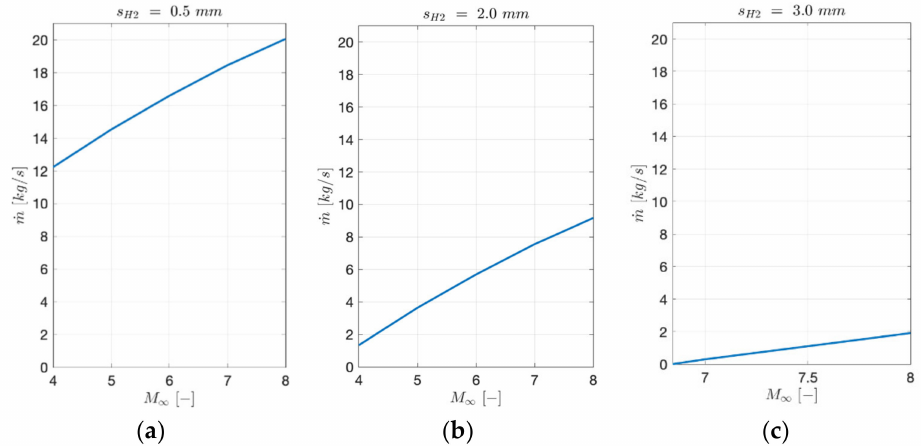
Figure 21. ( a ) Variation of the overall air mass flow supplied by the ECS with Mach number for the cabin (thickness of the boil-off hydrogen insulation layer equal to 0.5 mm); ( b ) variation of the overall air mass flow supplied by the ECS with Mach number for the cabin (thickness of the boil-off hydrogen insulation layer equal to 2 mm); ( c ) variation of the overall air mass flow supplied by the ECS with Mach number for the cabin (thickness of the boil-off hydrogen insulation layer equal to 3